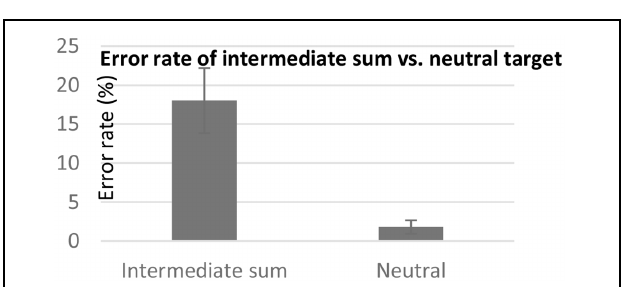
FIGURE 2 | Mean response time (RT) for rejecting a digit representing the intermediate sum versus a neutral digit. Error bars represent standard error mean.